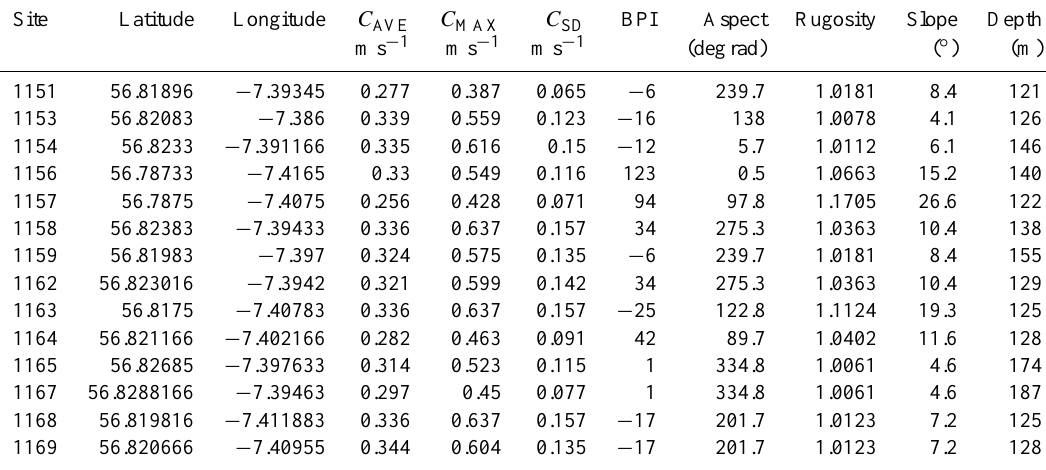
Table 1. Topographic and hydrographic variables for each of the 14 sites at the reef complex. Site Latitude Longitude Aspect Rugosity